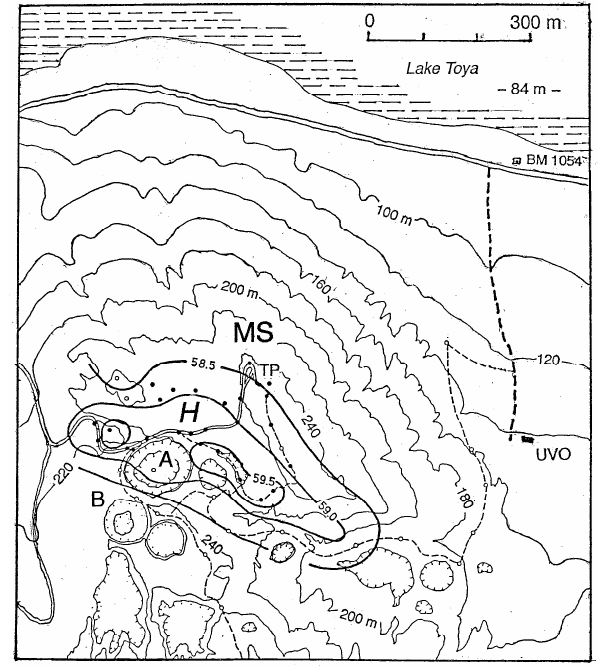
Fig. 9. Bouguer gravity anomalies in mgal around MS hill. High anomaly is predominant.